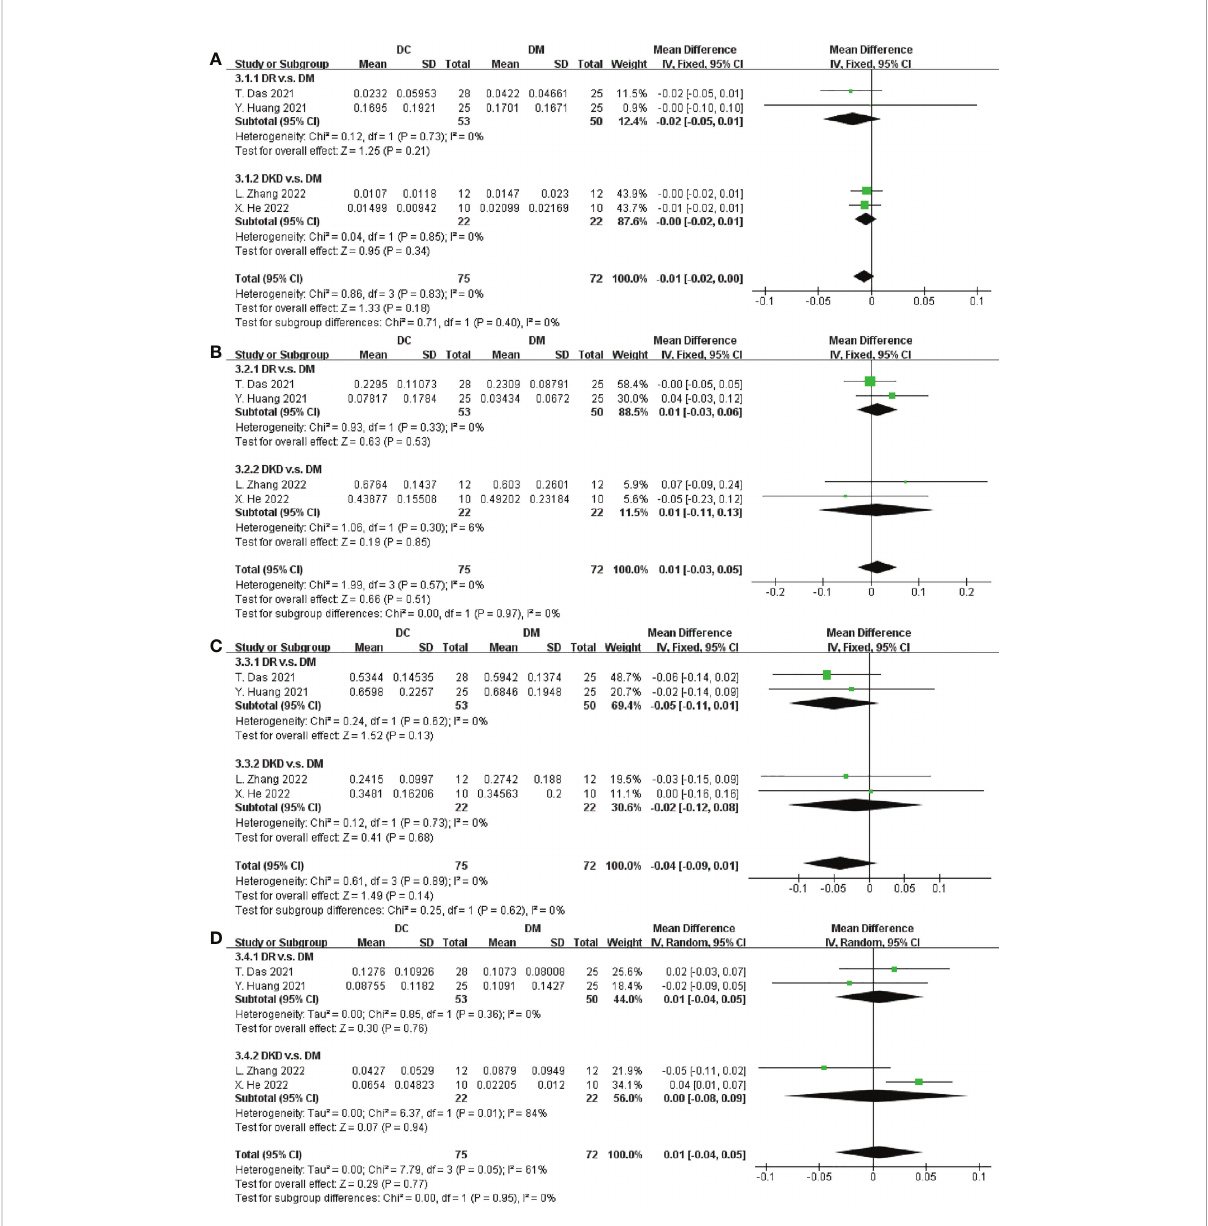
FIGURE 4 Forest plots of microbiota at the phylum level in DC v.s. DM. (A) Actinobacteria; (B) Bacteroidetes; (C) Firmicutes; (D)